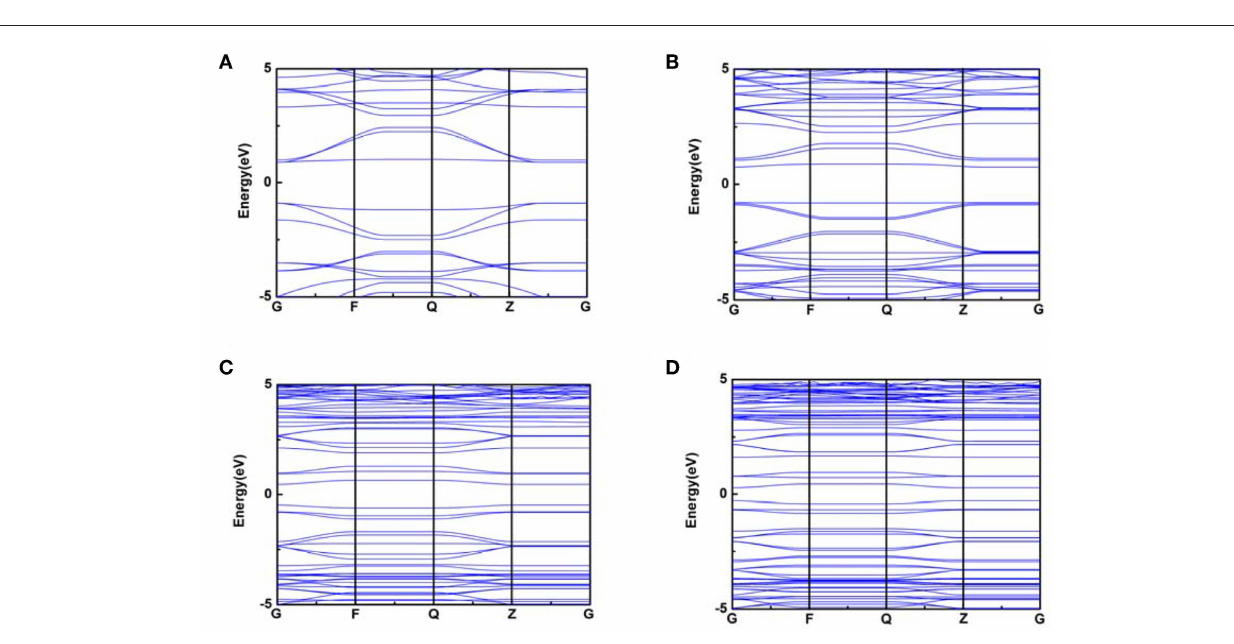
fluidity which could facilitate the ORR process. Through Charge Density Analysis, we found an important law firstly. Specially, the charge density became lower with the addition of